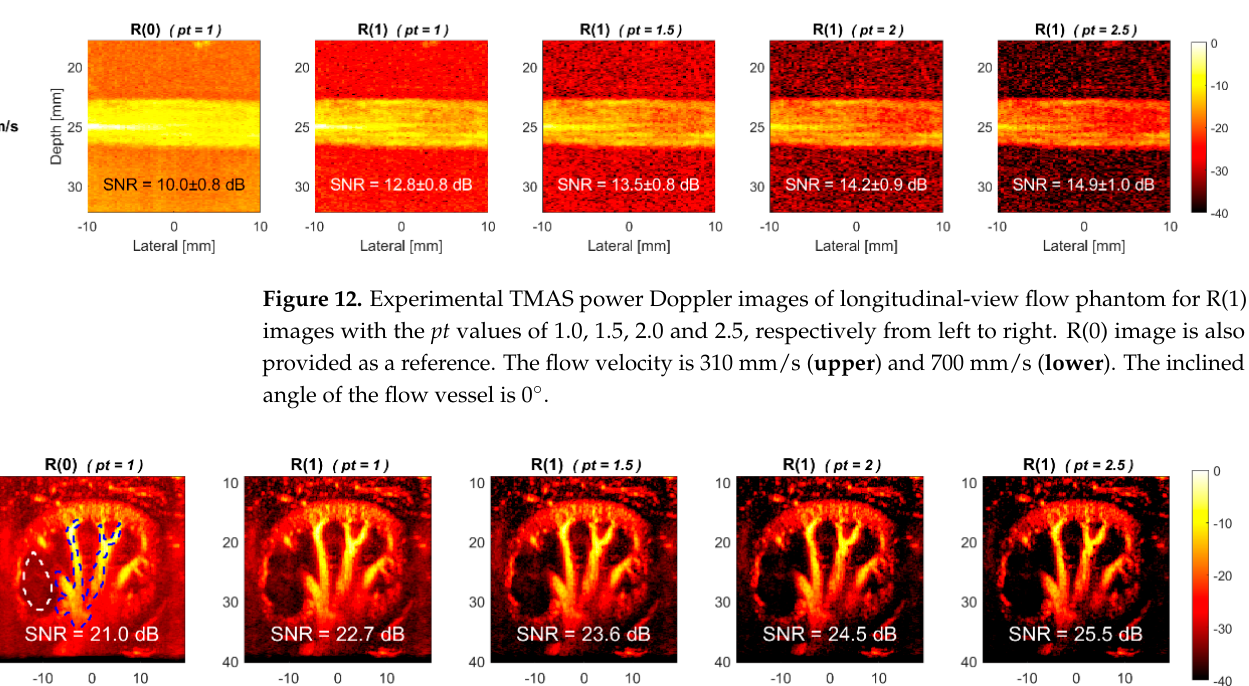
Figure 13. Experimental TMAS power Doppler images of in vivo rabbit’s kidney for R(1) images with the pt values of 1.0, 1.5, 2.0 and 2.5, respectively from left to right. R(0) image is also provided as a reference.